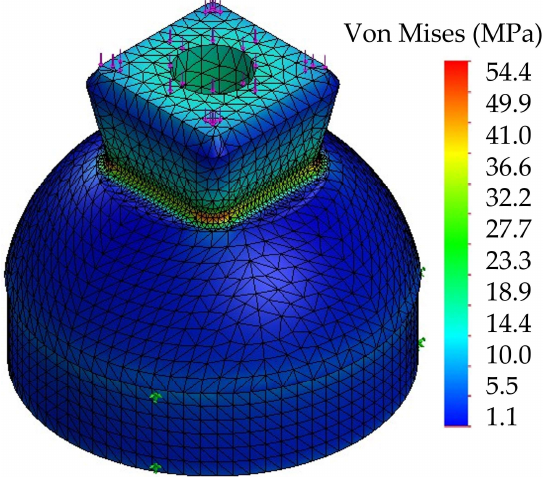
Figure 5. Exemplary results of mesh convergence: ( a ) results for kneecap displacement as a function of the number of elements; ( b ) displacement in the upper axis of the shock absorber as a function of the number of